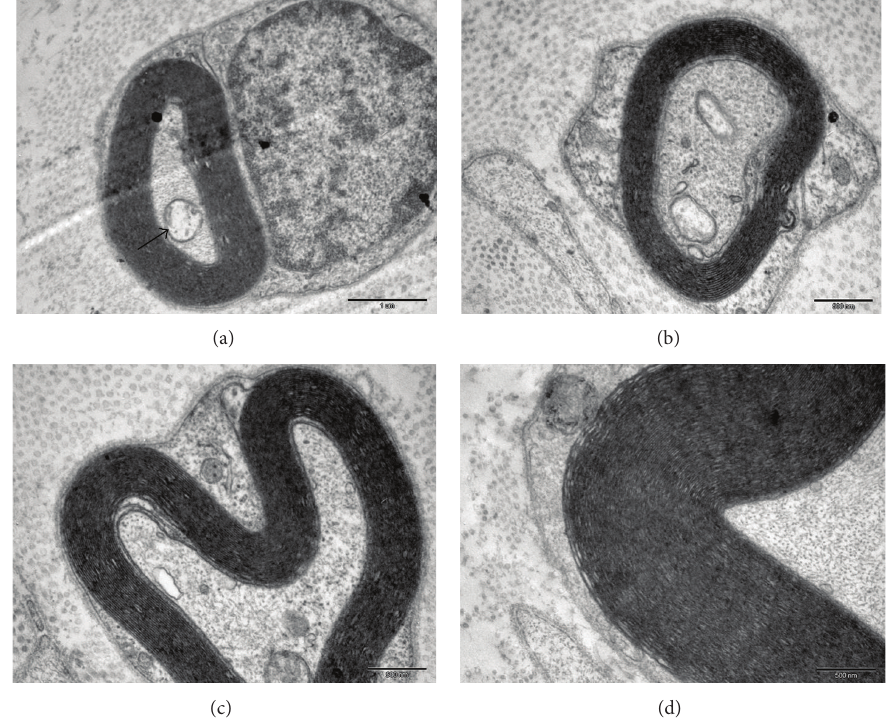
Figure 4: Transmission electron microscopy (TEM) of the femoral nerve from the experiment group. Axon-like structures were wrapped in myelin (a) and mitochondria were also observed (arrow). The thickness of the myelin sheath showed significant difference between the three groups ((b), (c), (d)). Scale bar: (a) 1 𝜇 m; ((b)–(d)) 500 nm.